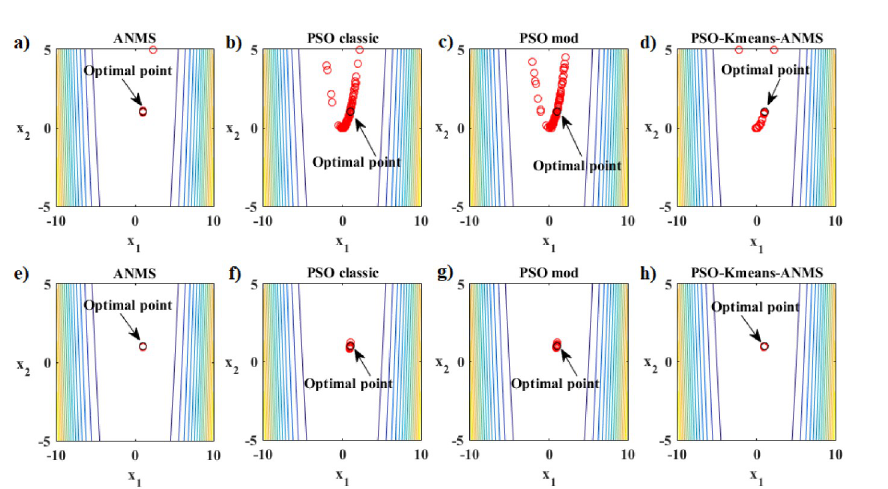
Fig 13. Simulations details for the Rosenbrock function. The 100 results obtained by the algorithms ANMS, PSO classic, PSO mod and PSO-Kmeans-ANMS for the swarms with 08 (upper) and 36 (lower) particles, respectively.